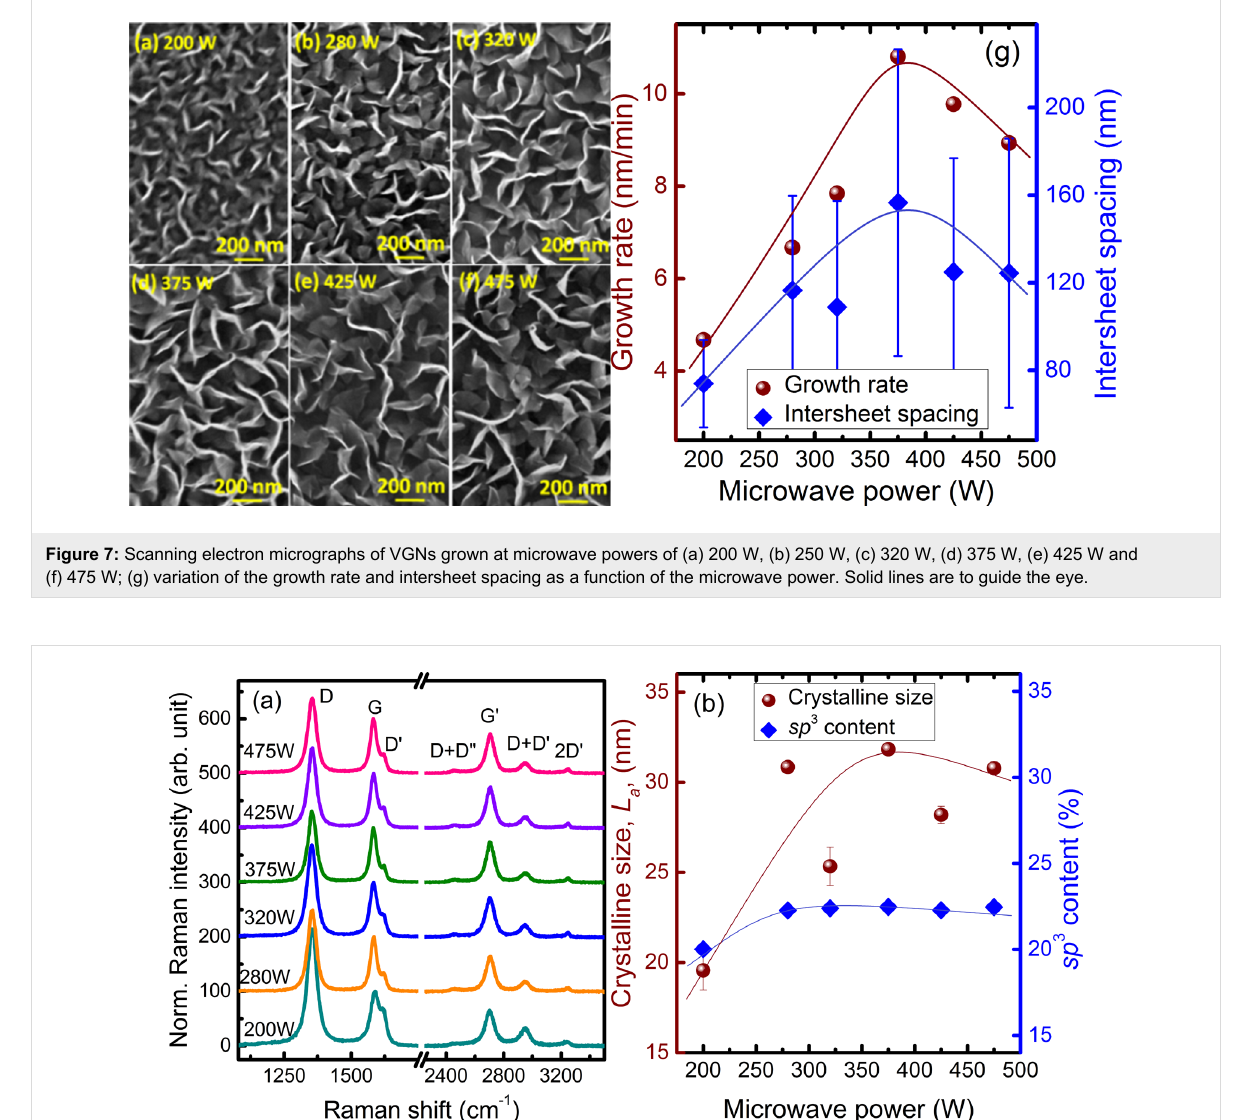
PECVD by means of: (i) reducing the formation of undesirable form of carbon species, (ii) reducing the amount of C 2 species by recombining with them to form CH x radicals, and (iii) etching of sp 2 -C, sp 3 -C and amorphous C at different